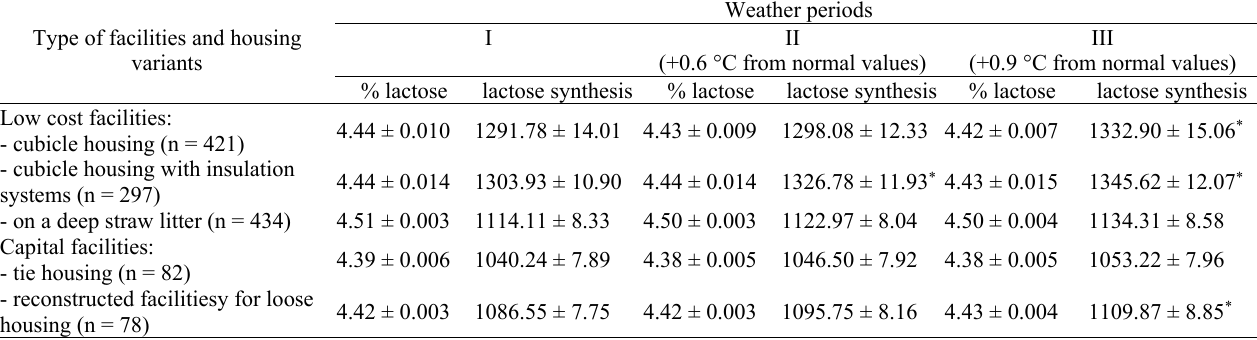
The average mass fraction of lactose in cow's milk (%) and its synthesis for research period, kg/head